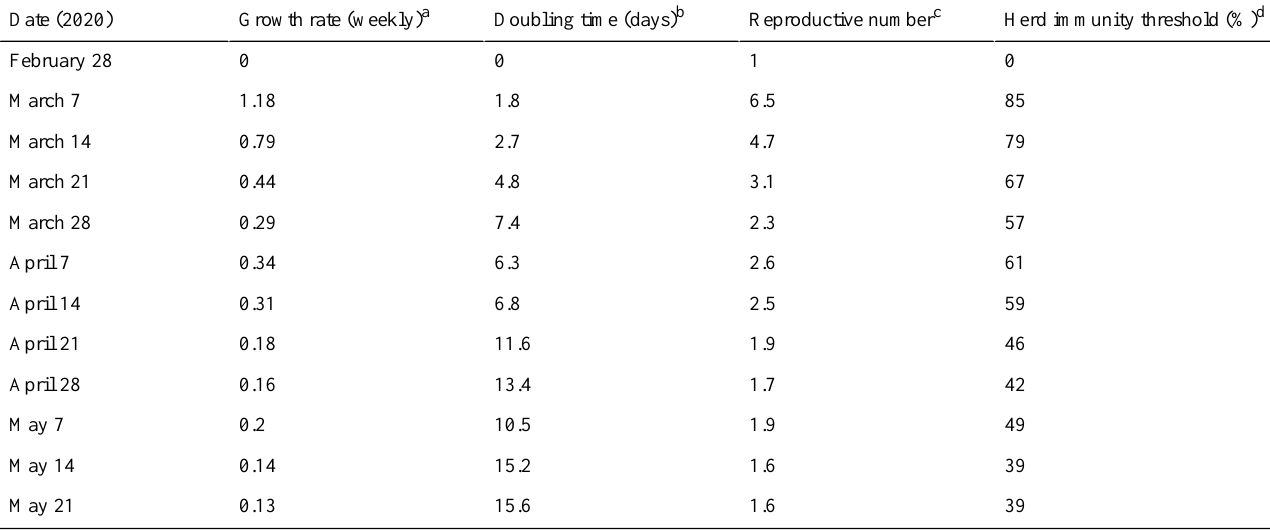
Table 1. Reproductive number (R 0 ) and corresponding herd immunity threshold of COVID-19 in Egypt, February-May 2020